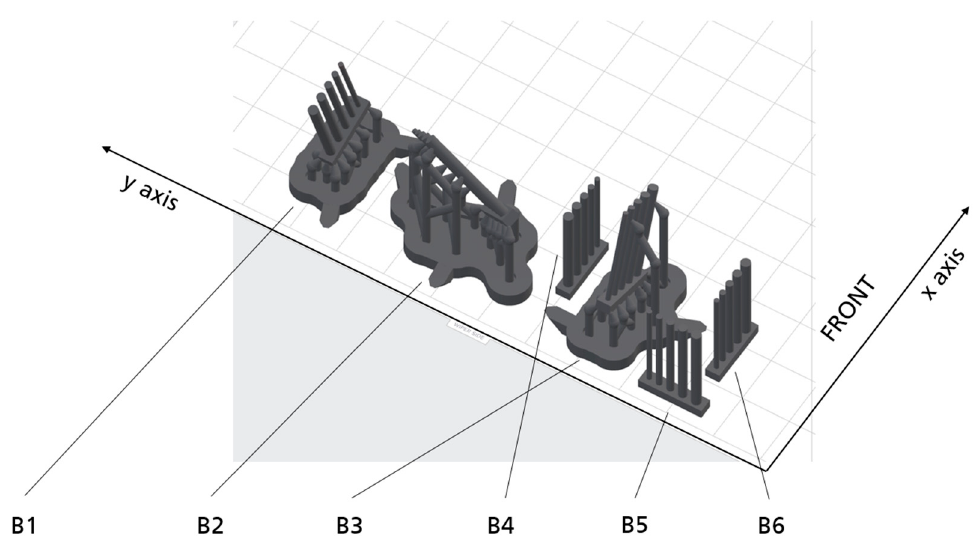
Figure 2. Alignment of the samples on the building platform - view from the slicer program.